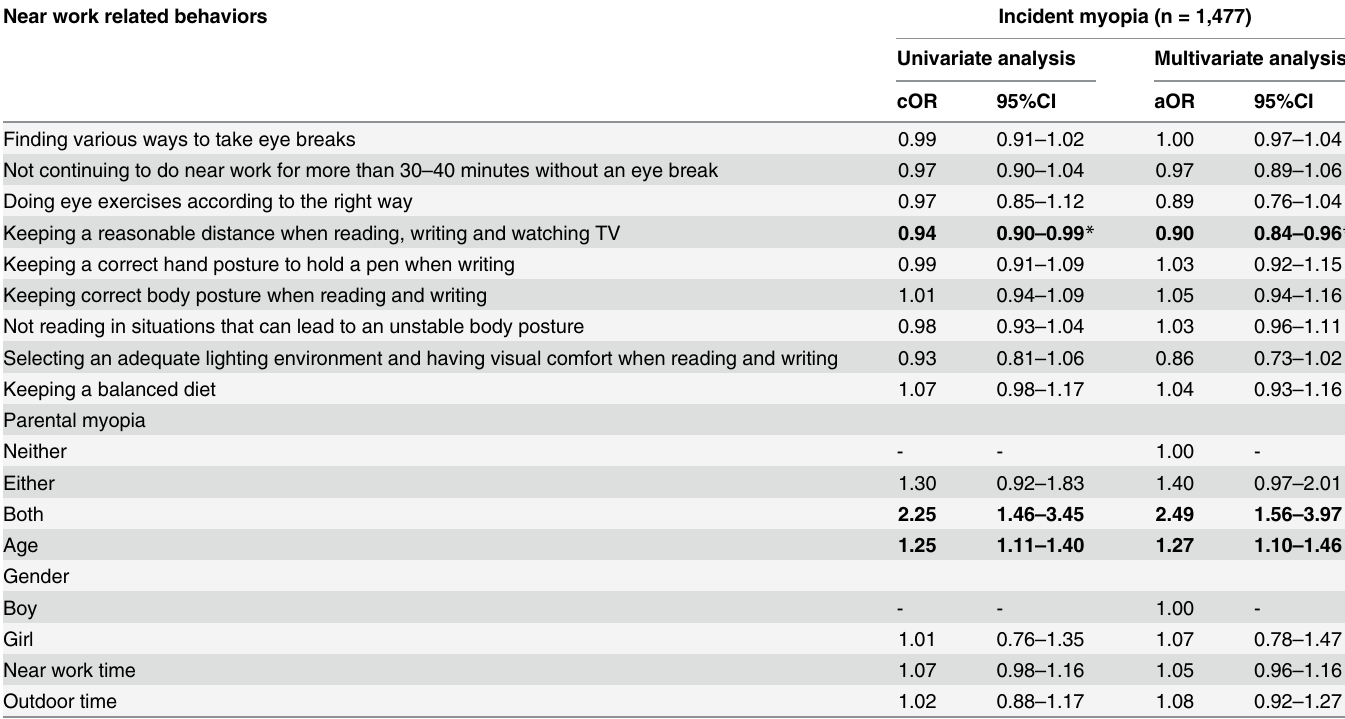
Table 6. Near work related behaviors associated with incident myopia within one year in students of grades 1 to 4 in Shanghai. Near work related